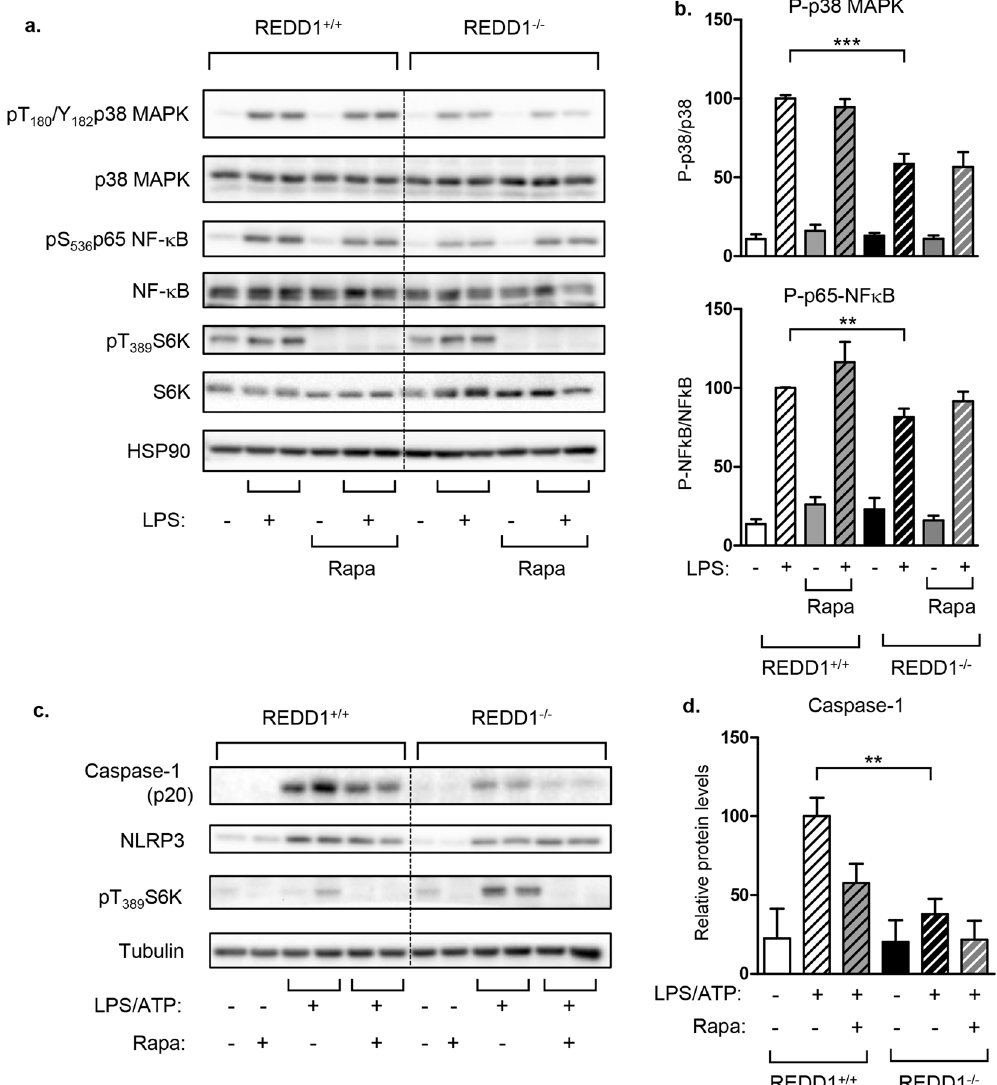
Figure 5. Inhibition of inflammation in REDD1 − / − BMDM was mTORC1 independent. ( a ) REDD1 + / + and REDD1 − / − BMDM were treated with rapamycin (Rapa) 40 nM for 45 minutes before being stimulated with LPS (100 ng/ml) for 20 minutes. Cell lysates were analyzed by immunoblots with indicated antibodies. ( b ) Quantification of phosphorylated proteins is shown (n = 3 independent experiments) with the value of REDD1 + / + treated with LPS taken as 100 ( c ) REDD1 + / + and REDD1 − / − BMDM were treated with rapamycin (Rapa) 40 nM for 45 minutes before being stimulated with LPS (100 ng/ml for 5 hours) and ATP (5 mM for 45 minutes). Cell lysates were analyzed by immunoblots with indicated antibodies. ( d ) Quantification of caspase-1 p20 normalized to tubulin is shown with the value of REDD1 + / + treated with LPS taken as 100 (n = 3 independent